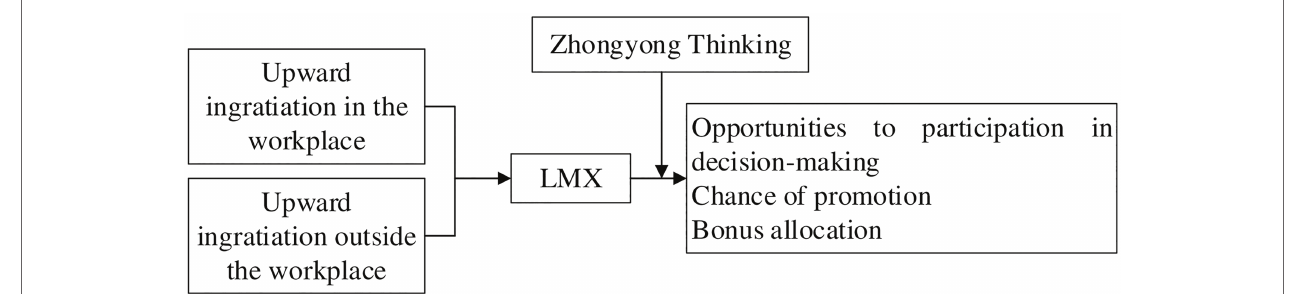
FIGURE 1 | Research